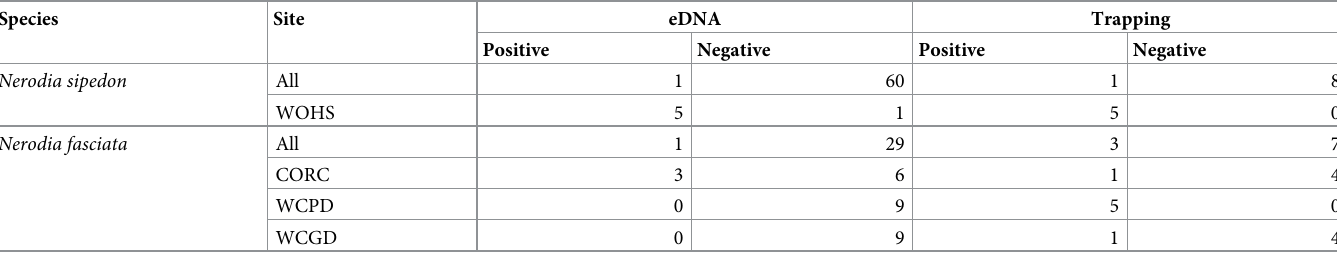
For the rows with “All” sites, the values are the number of sites with positive and negative detections, where a single positive eDNA sample or single capture of a Nerodia counted as a positive. For the rows with individual sites (WOHS, CORC, WCPD, WCGD), the values are the number of eDNA samples or trapping surveys in which Nerodia were detected or